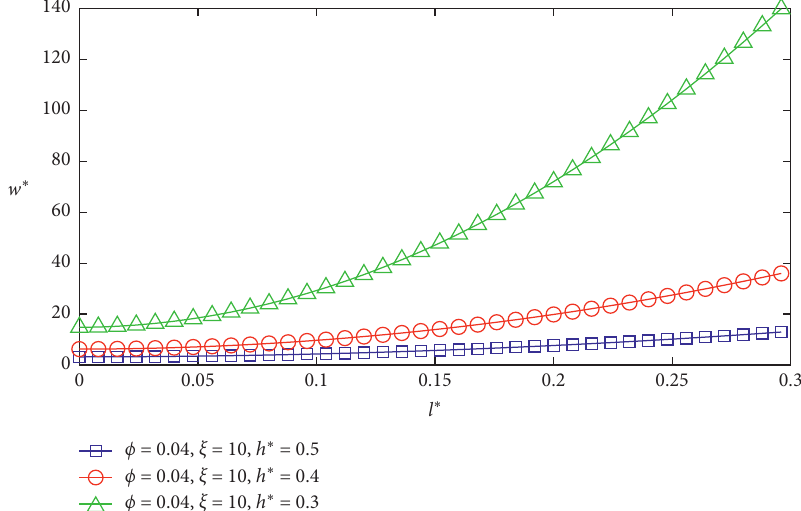
Figure 6: Dimensionless load capacity versus couple stress parameter l ∗ for different values of h ∗ at ξ � 10 and Φ � 0 . 04.